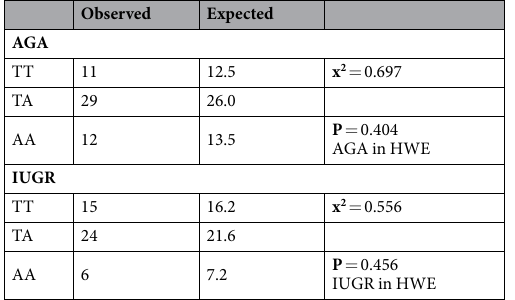
Table 7. Hardy-Weinberg Equilibrium analysis for children born IUGR and